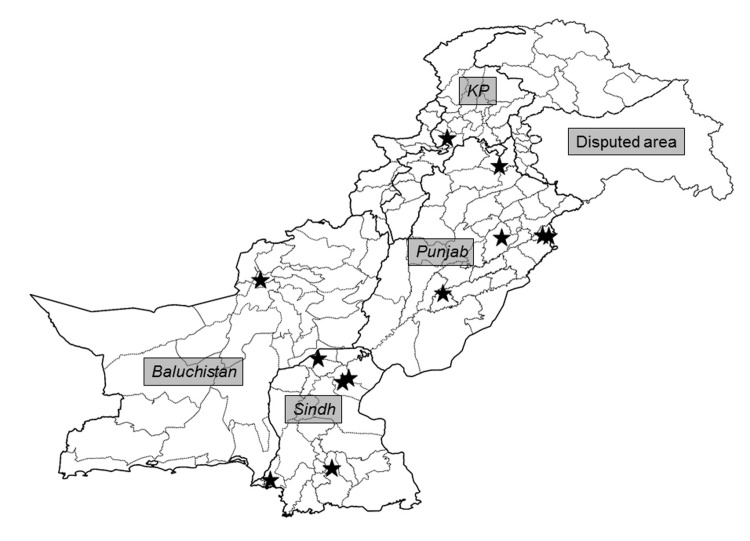
Location of 12 study sites in 10 Pakistani districts.KP is Khyber Pakhtunkhwa province.